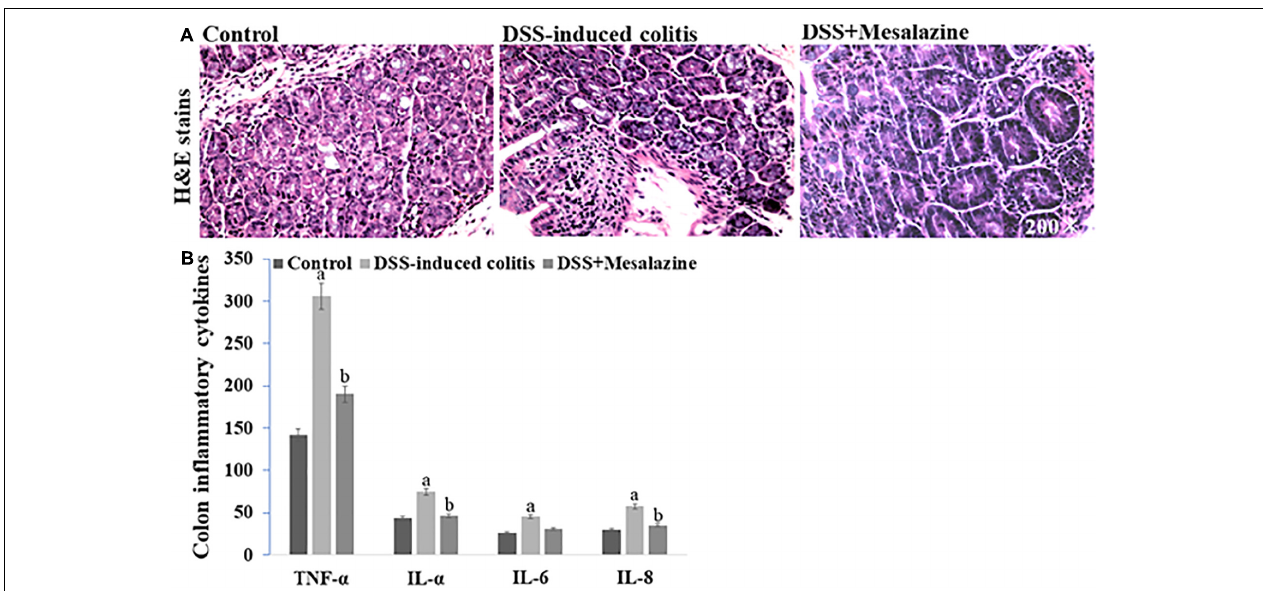
FIGURE 4 | In vivo effects of mesalazine treatment on DSS-induced colitis. (A) Hematoxylin and eosin staining show the structural changes including visible crypt abscess, inflammatory infiltration, and cytoclasis in DSS-induced colitis. These alterations were reversed by mesalazine treatment. (B) Mesalazine treatment relieved DSS-induced inflammatory cytokines including TNF- α , IL-1 α , IL-6, and IL-8 in the colon samples via its anti-inflammation